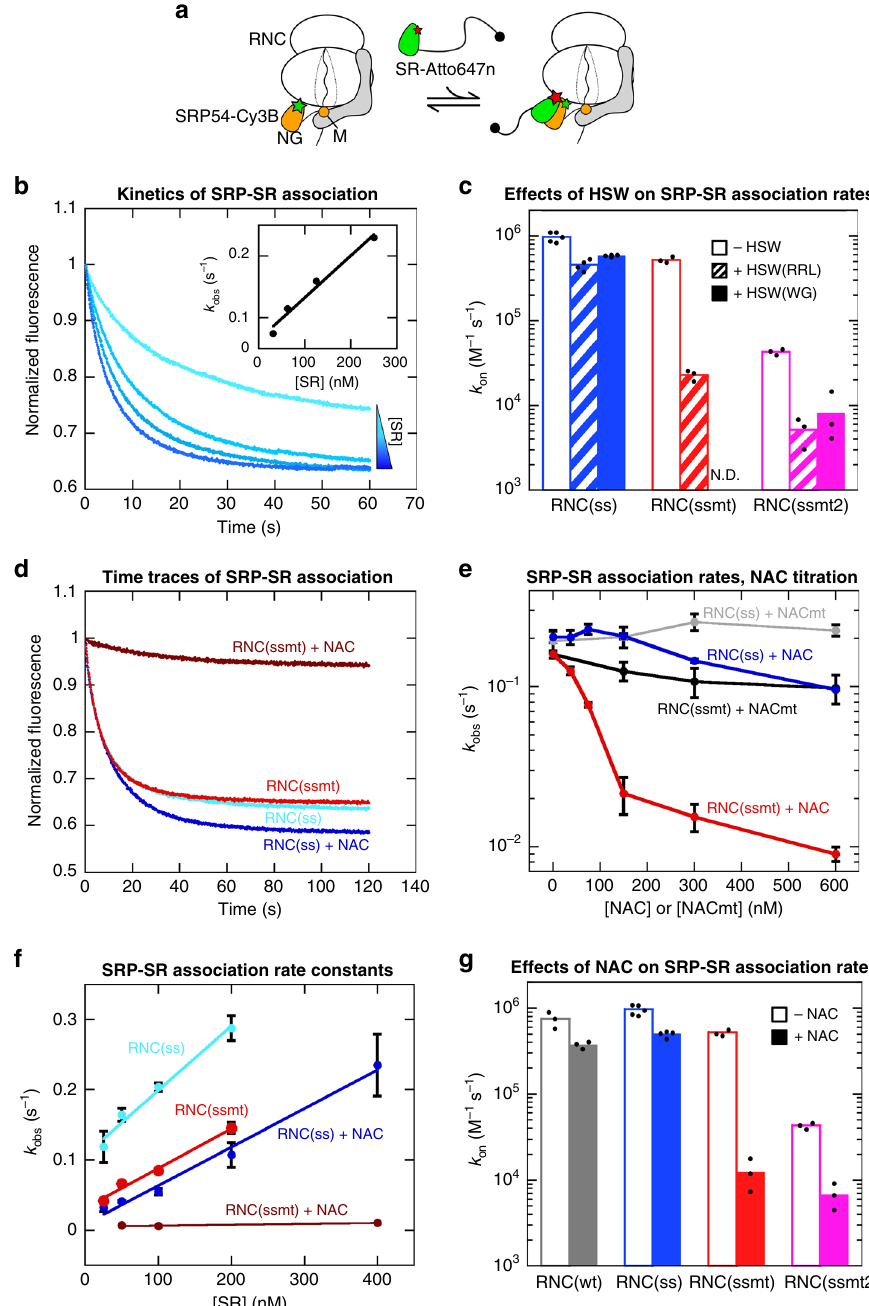
puri fi cation via an N-terminal 3× FLAG tag on the nascent chain (Supplementary Fig. 1a), and sucrose gradient centrifugation 34 .